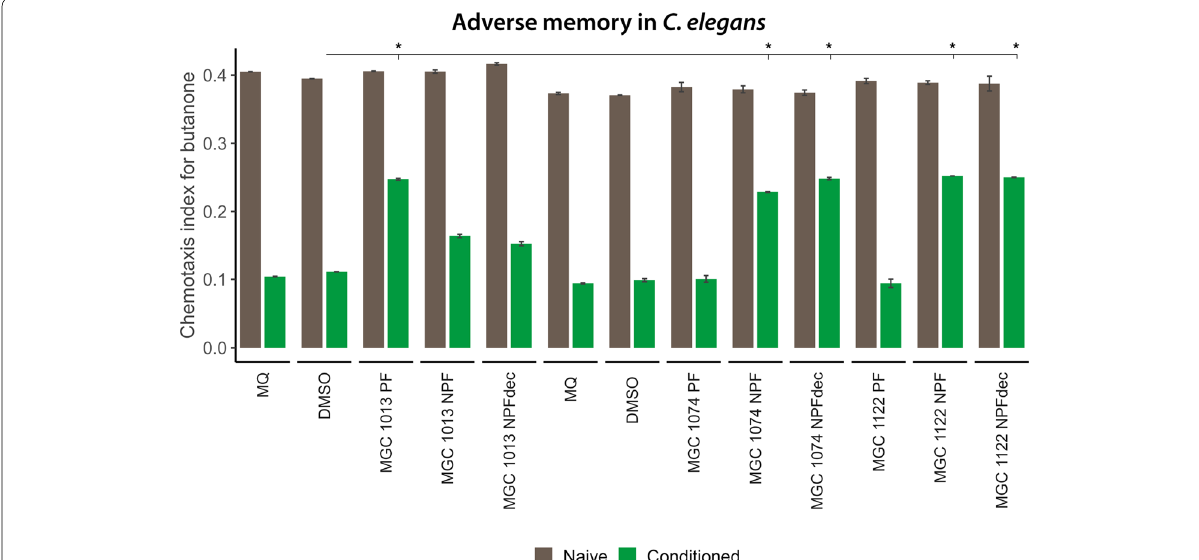
Fig. 6 Effect of cannabis fractions on adverse memory. The effect of polar fractions (PFs; 100 μg/mL) and a non‑toxic concentration of the non‑polar fractions (decarboxylated (NPF dec ; 5 μg/mL) and non‑decarboxylated (NPF; 5 μg/mL) of the cannabidiol (CBD)‑rich cannabis variety MGC 1013, MGC 1074 and MGC 1122 was tested on adverse memory with conditioning in the presence or absence of butanone. Brown bars indicate the naïve population, green bars the adversely butanone conditioned treatment groups. The PF of MGC 1013 as well as the NPF of MGC 1074 and MGC 1122 reduce the avoidance behavior of nematodes towards butanone (as can be seen by a higher chemotaxis level in conditioned group). MQ indicates the Milli‑Q water control group, DMSO (dimethyl sufoxide) the vehicle control. t tests were used to compare the vehicle control conditions (DMSO) to the experimental conditions for each learning condition. * false discovery rate (FDR)‑corrected p < =